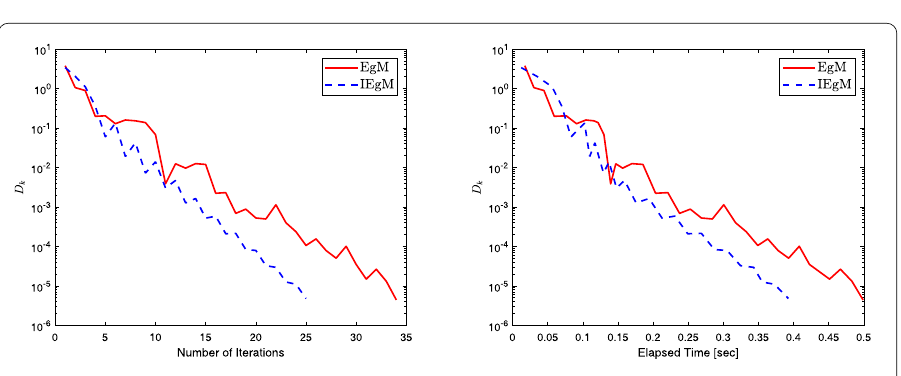
Figure 6 Computational comparability of Algorithm 2 with Algorithm 3.1 in [36] for M = 10